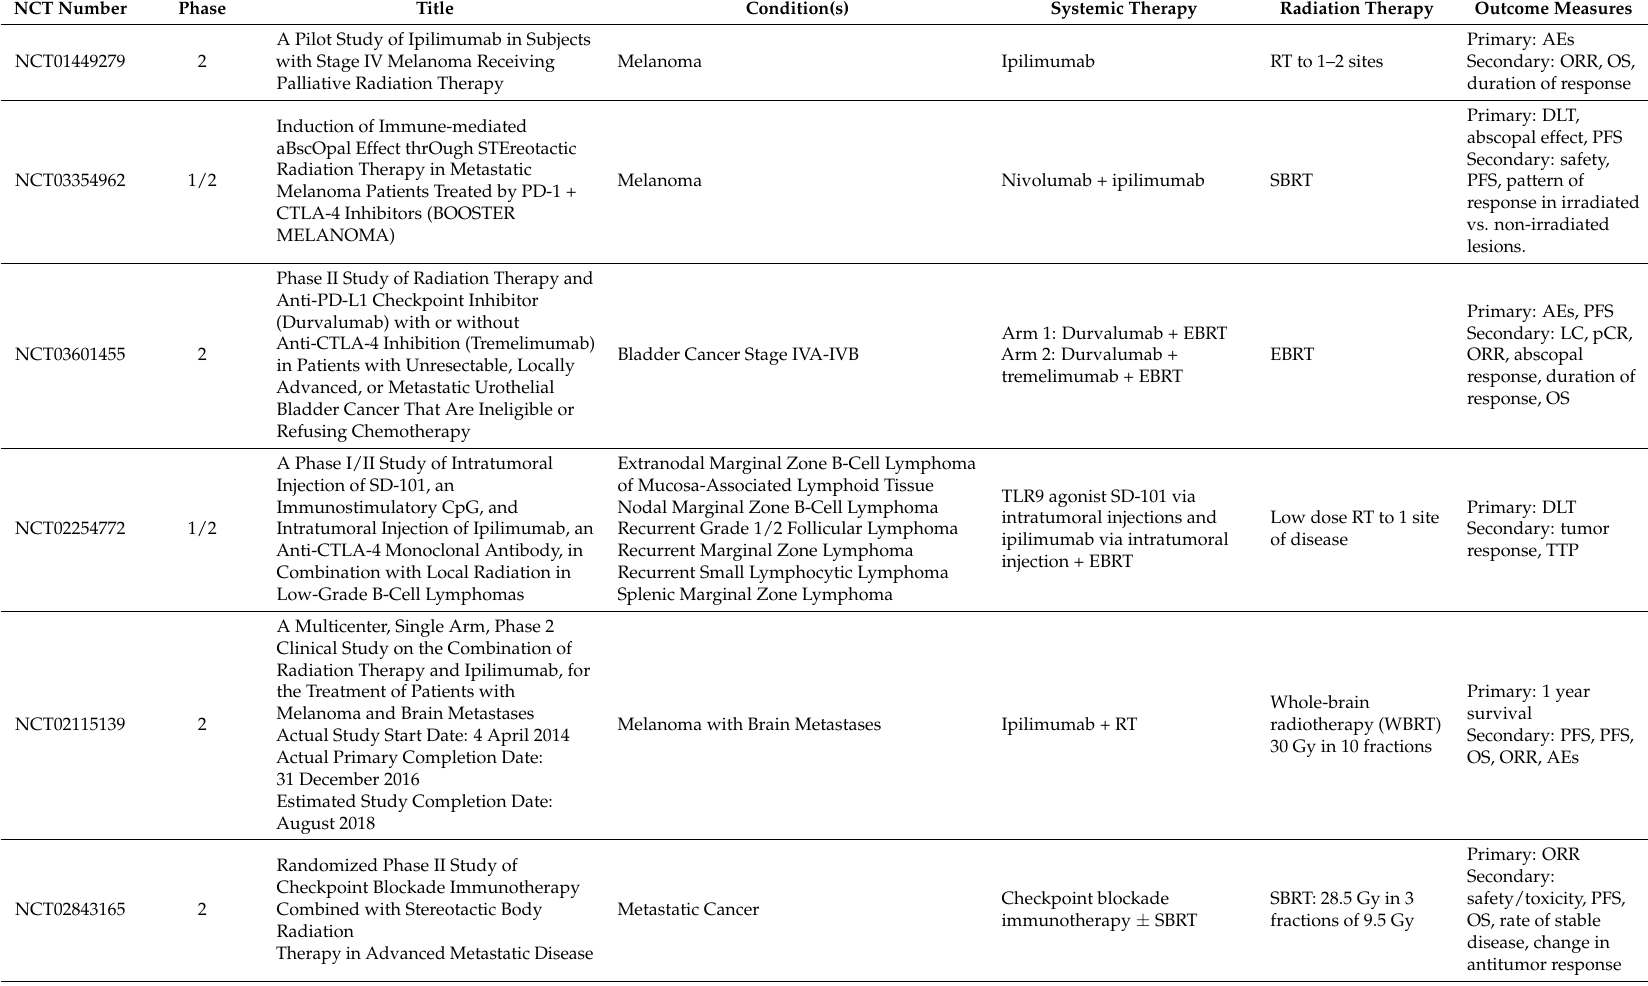
Table 1. Active Clinical Trials Combining CTLA-4 Blockade with